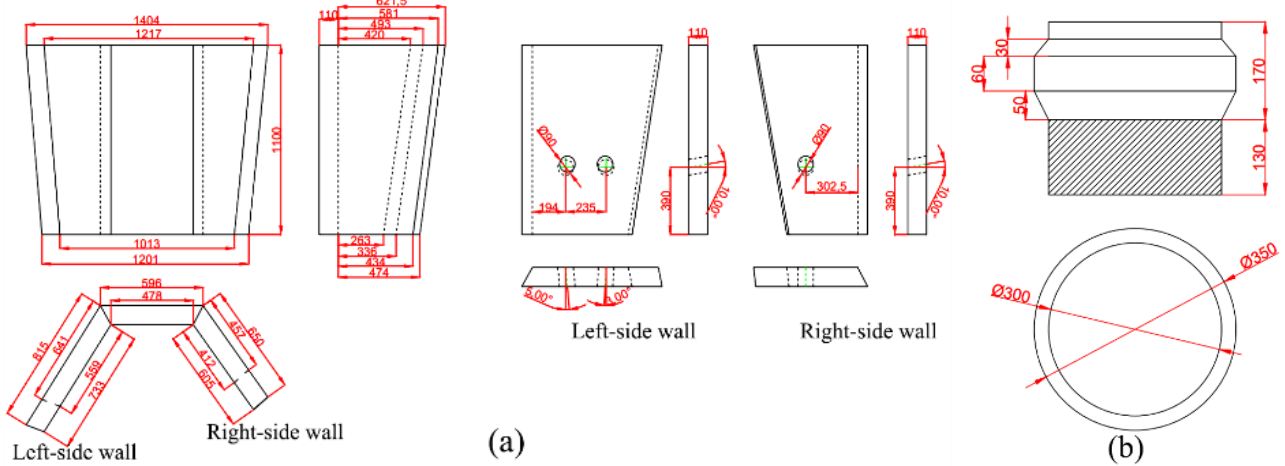
Figure 2. Retaining wall structure ( a ) and vortex inhibitor ( b ) in optimized case B and their geometry sizes, unit: mm. Table 6. Flow characteristic parameters of the two experimental schemes.